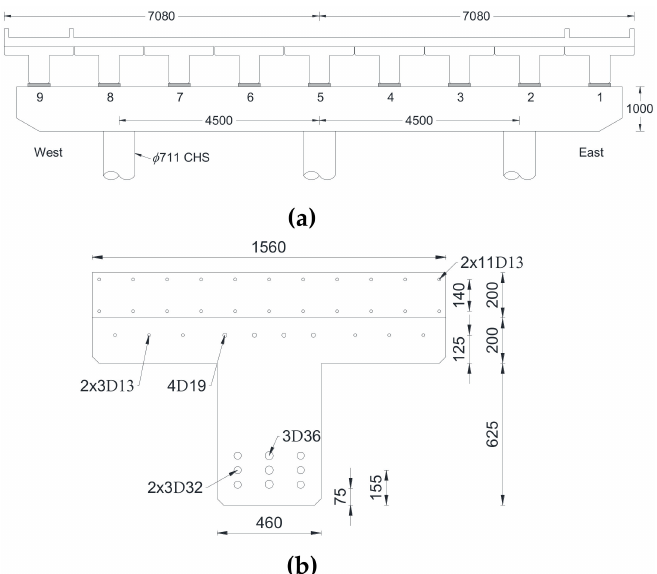
Figure 2. Typical RC bridge in TPS: ( a ) Cross-section of the bridge looking to the harbor; ( b ) The details for one RC deck